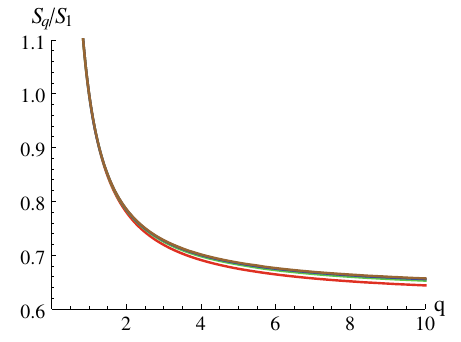
Fig. 2 S q / S 1 as a function of q for various d . Here C = − 3 / 2 and